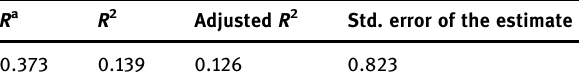
Table 11: Summary for model one